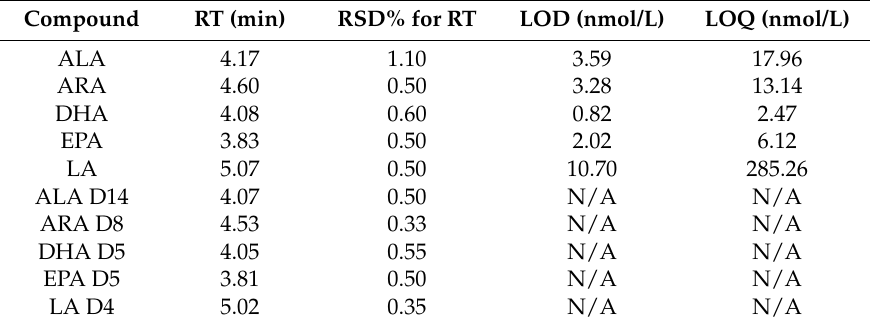
Table 1. Retention times (RT) and their relative standard deviation (RSD), limit of detection (LOD), and limits of quantification (LOQ) for each compound.